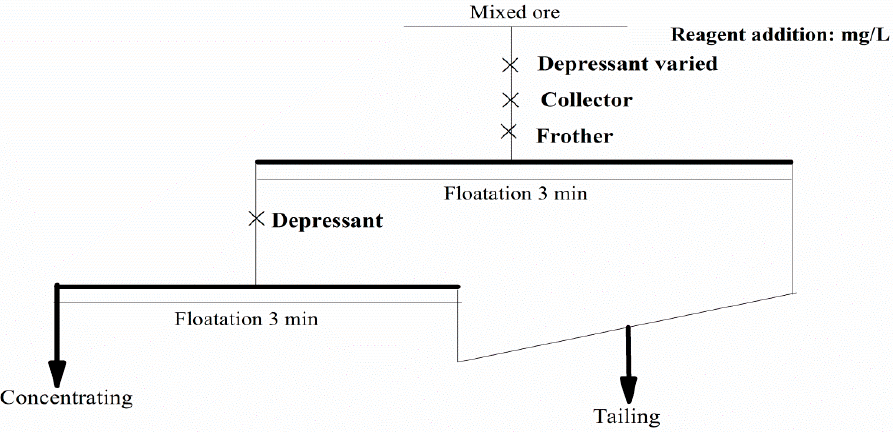
Figure 3. The beneficiation flow sheet of mixed ore experiment.